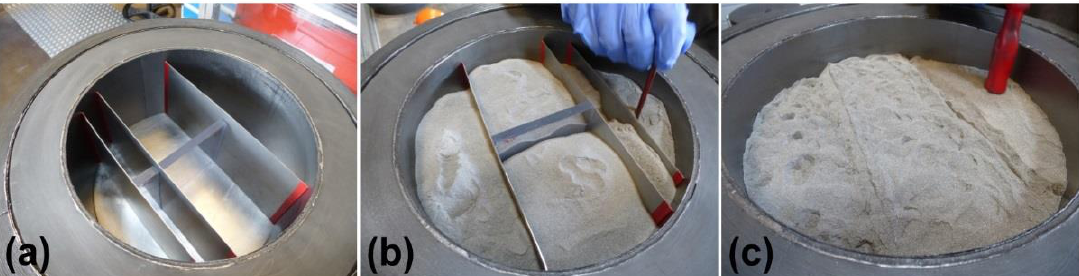
Figure 3. Photographs of the large-scale manual powder layup at Kennametal Ltd. UK, showing; ( a ) titanium sheet and Perspex dividers in the 250 mm diameter mould; ( b ) dissimilar powders filled in the separate sections with agitation of powder using a brush; and ( c ) flattening of powder after the dividers have been removed.